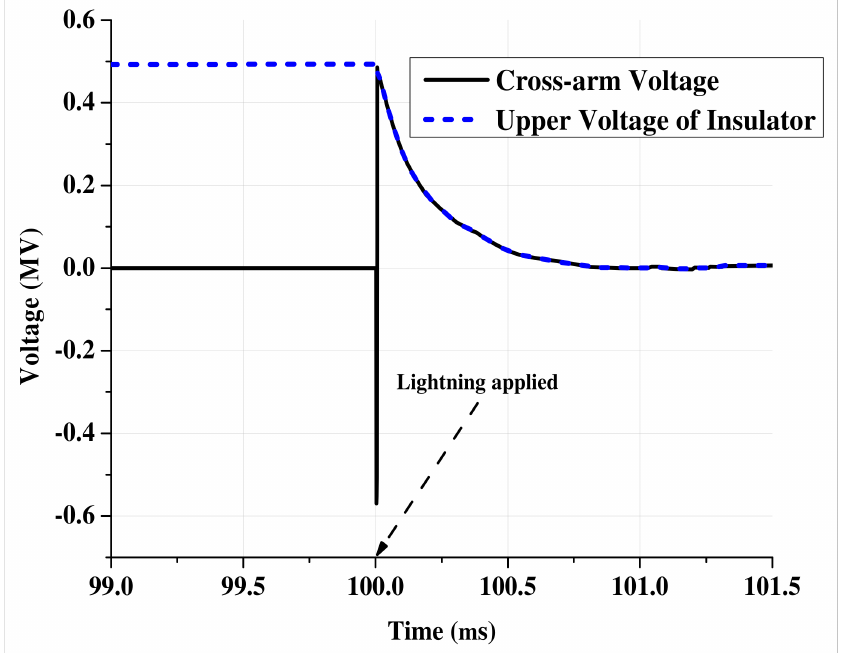
Figure 19. Voltage at tower cross-arm point and upper point of insulator at 28 kA and 125 Ω grounding